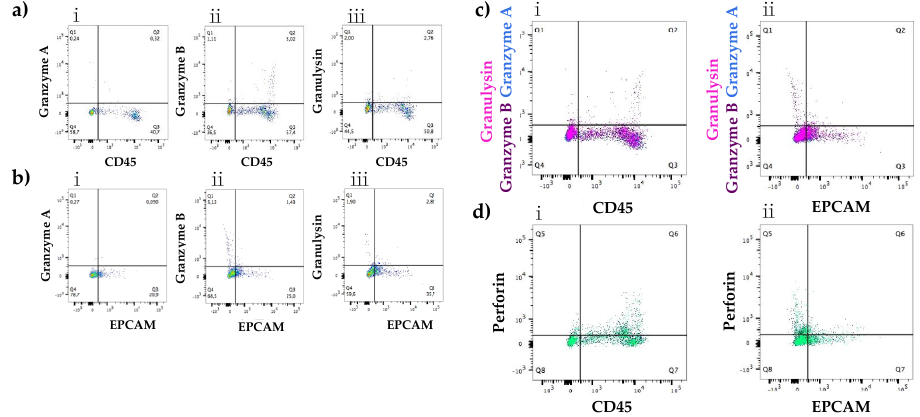
Figure 5. Co-expression of immune proteins granulysin, granzyme A, granzyme B and perforin with immune cell marker CD45 or epithelial marker EPCAM. Granzyme A, granzyme B and granulysin were all co-expressed with CD45 (0.3%, 5.0% and 2.8% respectively) positive cells ( a ( i – iii )), whereas little co-expression was found between the immune proteins and the epithelial cell marker EPCAM (0.1%, 1.4% and 2.8% respectively) ( b ( i – iii )). Superposition of the co-expression of granulysin, granzyme B and granzyme A in CD45 + ( c ( i )) and EPCAM + ( c ( ii )). Perforin co-expression with CD45 + ( d ( i )) cells at a level of 23.7% whereas only 5.2% with EPCAM + ( d ( ii )) cells. Nutrients 2018 , 10 , x FOR PEER REVIEW